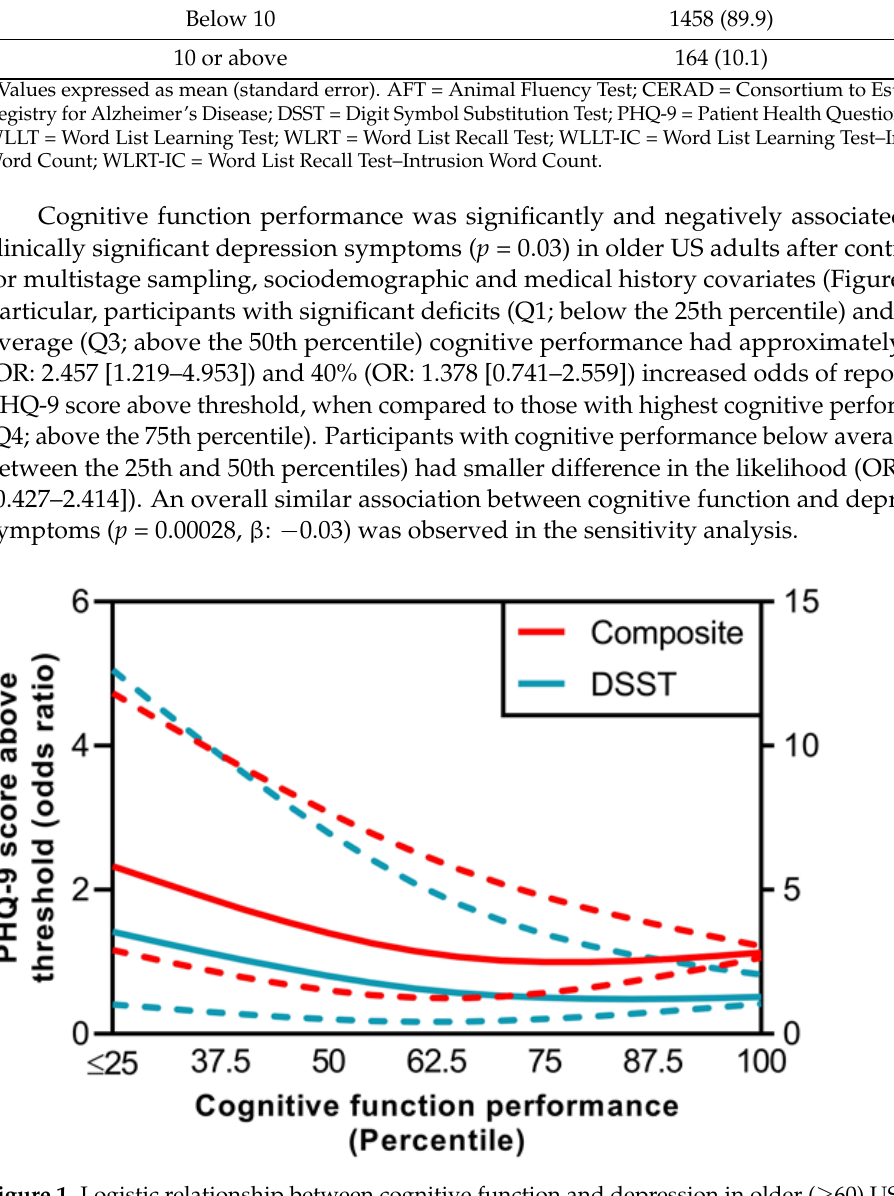
Figure 1. Logistic relationship between cognitive function and depression in older ( ≥ 60) US adults after adjustment for sociodemographic factors and medical history in terms of self-reported chronic condition and incidence of stroke or memory–cognitive function loss. Cognitive function was expressed as a composite score and on a test-by-test basis based on the Consortium to Establish a Registry for Alzheimer’s Disease Word List Learning Test, the Word List Recall Test, the Intrusion Word Count Test, the Animal Fluency Test, and the Digit Symbol Substitution Test. Depression was defined as clinically significant depression symptoms based on the standard cut-off point of Patient Health Questionnaire-9 (PHQ-9) score of 10 or greater. Significant associations between cognitive function including its components and depression symptoms are shown. Solid lines represent the estimated odds ratio and the area bound by the dashed lines represents the 95% confidence interval. Cubic splines with three knots were used for modelling. The highest quartile of cognitive performance and PHQ-9 score above threshold were used as the